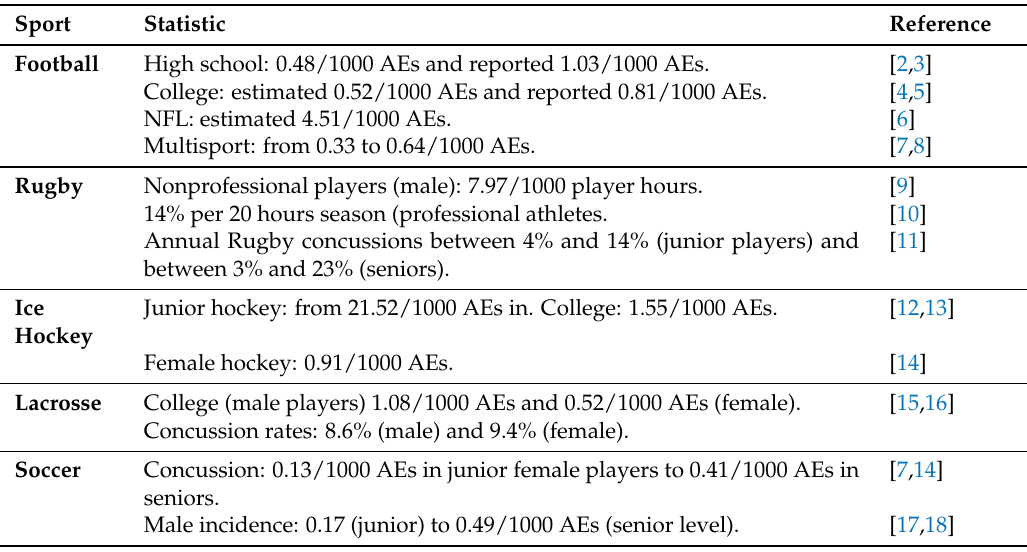
Table 1. Concussion rates in different sports [1].